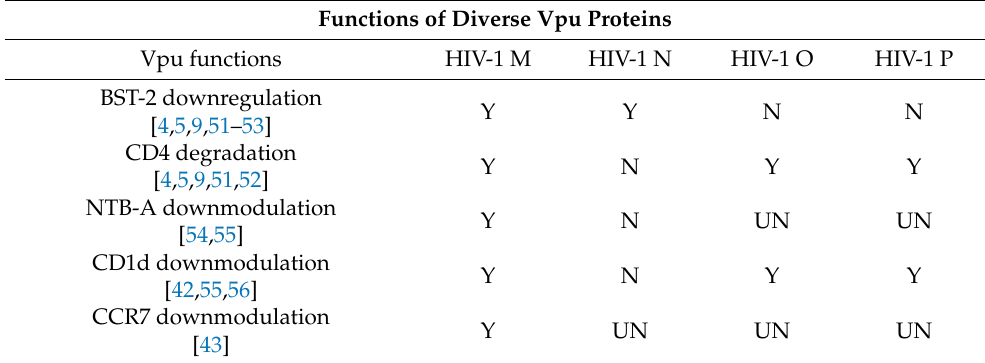
Table 1. Function of Vpu proteins of different HIV-1